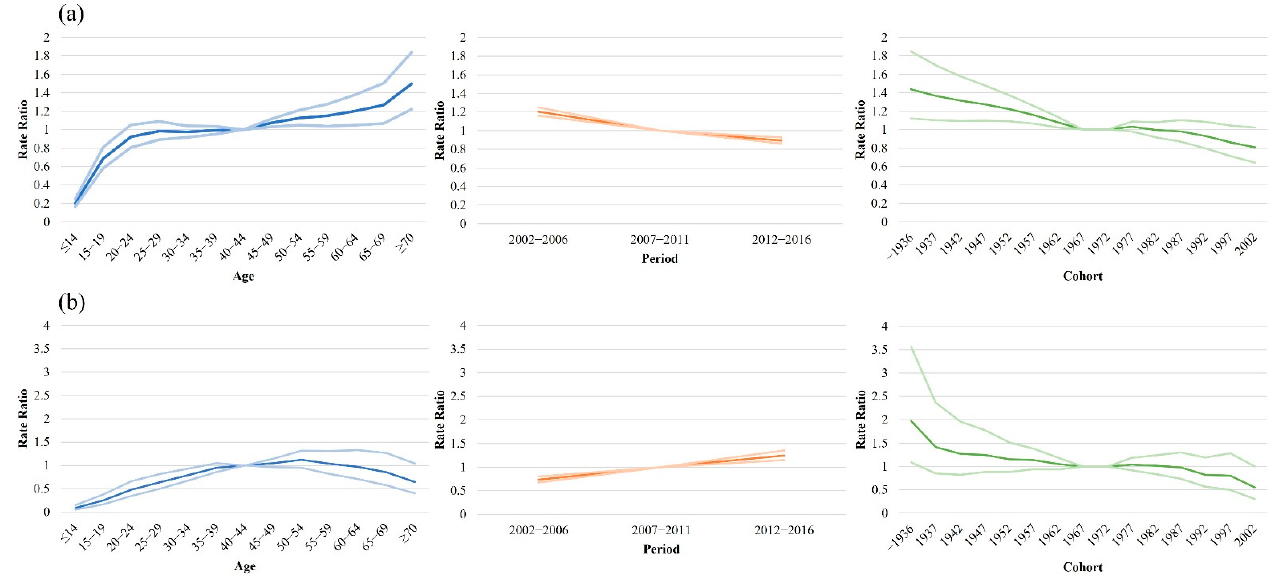
Figure 3. Three-factor age–period–cohort model analysis for incidence rate of ( a ) psoriasis and ( b ) psoriatic arthritis.